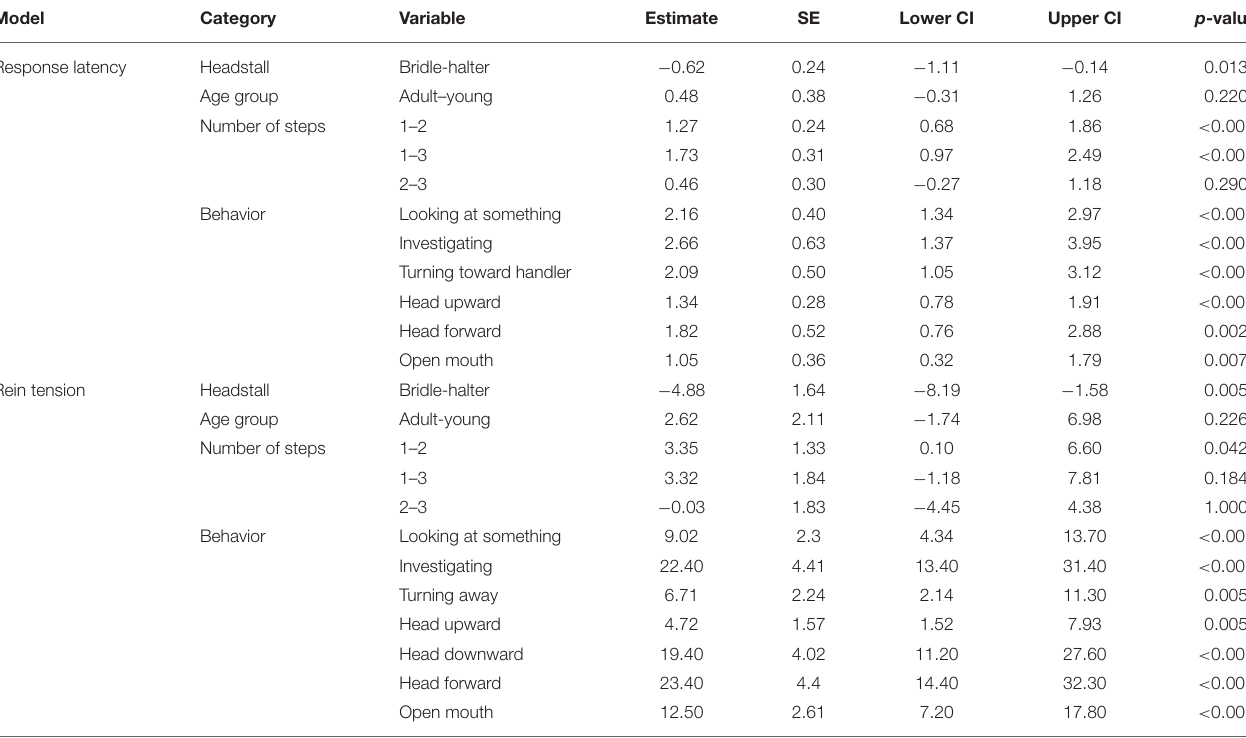
TABLE 3 | Contrasts between variables within each category for the response latency model and the rein tension model.